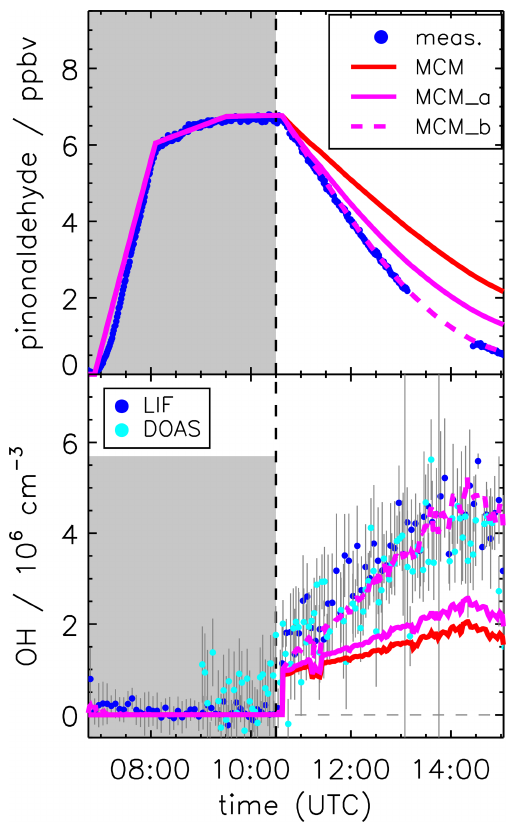
Figure 7. Pinonaldehyde and OH time series during the experi- ment without OH scavenger. Model runs were done either using the MCM with parameterization of pinonaldehyde photolysis fre- quencies (MCM) or with measured values for photolysis frequen- cies (MCM_a; see the text for details). The model MCM_b was ad- ditionally constrained to measured HO 2 concentration, resulting in an agreement between modeled and measured (LIF and DOAS) OH concentrations. Grey-shaded areas indicate times when the chamber roof was